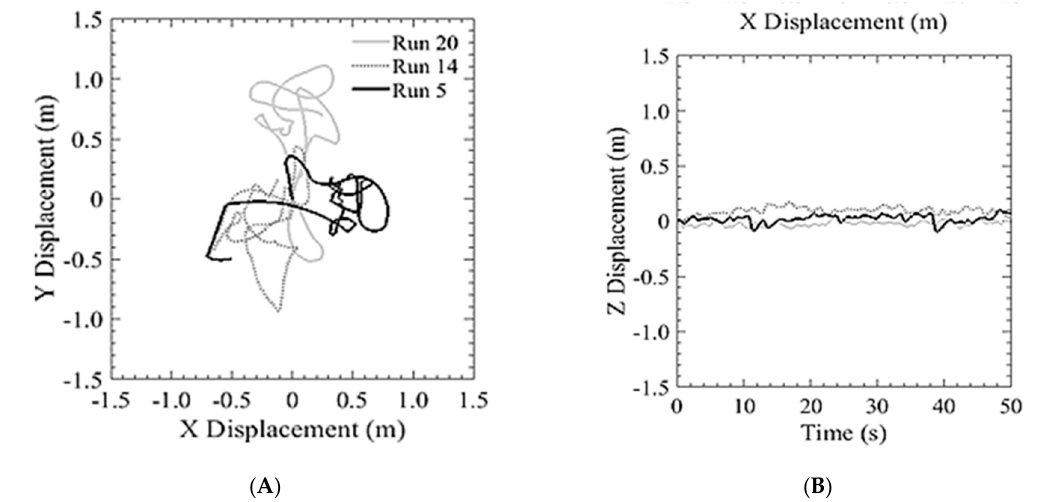
Figure 17. Position hold performance of optical flow and hybrid altitude controller: ( A ) Lateral position hold; ( B ) Vertical position hold.